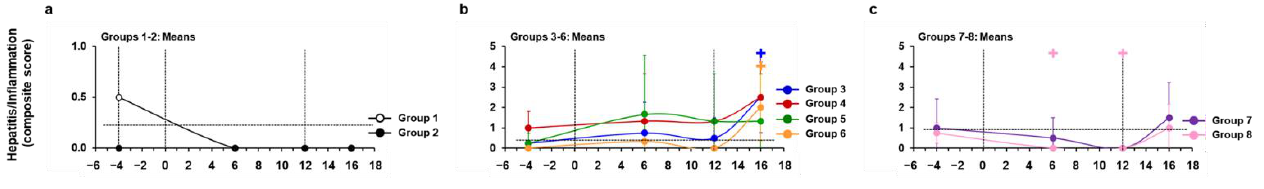
Figure 12. Treatment with hzVSF at the high dose or with TAF, alone and together with hzVSF at an intermediate dose, reduces inflammation in the liver. Comparison of mean composite scores of portal and sinusoidal hepatitis of ( a ) Groups 1 – 2 treated with placebo or hzVSF at a high dose, ( b ) Groups 3 – 6 treated with placebo or hzVSF at a low, intermediate, and high dose, and ( c ) Groups 7 – 8 treated with TAF, alone or in combination with hzVSF at an intermediate dose, relative to the pretreatment baseline (week −4). Vertical lines indicate the standard error of the mean. Horizontal dotted lines present the mean composite score of Groups 1 – 2, Groups 3 – 6, or Groups 7 – 8 at baseline. The composite score in Group 8 was significantly reduced compared to the baseline at weeks 6 and 12 ( +: p < 0.05). Compared to the baseline, the composite score in Group 3 and Group 6 was significantly increased after the EOS (+: p < 0.05). The composite score was derived from the sinusoidal hepatitis score plus the portal hepatitis score. Composite score: 0 = absent, >0 – 2 = mild, >2 – 4 = moderate, and >4 = marked to severe hepatitis/liver inflammation.